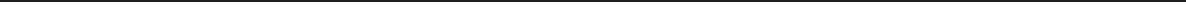
Fig. 6 ZCCHC3 binds to dsDNA and facilitates the binding of cGAS to dsDNA. a ZCCHC3 enhances the binding of cGAS to dsDNA. HEK293 cells were transfected with the indicated plasmids. Twenty hours later, the cell lysates were incubated with biotinylated-HSV120 and streptavidin-Sepharose beads for in vitro pull-down assays. The bound proteins were then analyzed by immunoblots with anti-HA and anti-ZCCHC3. b ZCCHC3-de fi ciency decreases the binding of cGAS to dsDNA in HEK293 cells. ZCCHC3-KO HEK293 clones were generated by the CRISPR-Cas9 method. ZCCHC3-KO and control HEK293 cells were transfected with HA-cGAS. Twenty hours after transfection, cells were collected for in vitro pull-down assays similarly as in a . c ZCCHC3-de fi ciency decreases the binding of endogenous cGAS to dsDNA in MLFs or MEFs. Zcchc3 + / + and Zcchc3 − / − MLFs or MEFs were collected for in vitro pull-down assays. The bound proteins were then analyzed by immunoblots with anti-cGAS and anti-ZCCHC3. d MST measurement of binding af fi nities. Binding af fi nities between the indicated recombinant proteins as well as between the indicated recombinant proteins and synthetic dsDNA HSV60 were measured by MST. The puri fi ed recombinant proteins were stained with Coomassie blue (right gel). e Effects of reconstitution of ZCCHC3 or ZCCHC3 (1-340) on HSV-1-induced transcription of downstream genes in Zcchc3 − / − MLFs. Zcchc3 − / − MLFs were reconstituted with murine ZCCHC3 or ZCCHC3(1-340) by lentiviral-mediated gene transfer. The reconstituted MLFs were left un-infected or infected with HSV-1 for 6 h before qPCR analysis. f Effects of ZCCHC3 on transcription of downstream genes induced by HSV120 in cGas + / + and cGas − / − L929 cells. cGas + / + and cGas − / − L929 cells stably expressing ZCCHC3 were transfected with HSV120 (3 μ g/ml) for 4 h before qPCR analysis. *P < 0.05, **P < 0.01 (unpaired t test). Data are representative of at least two experiments with similar results (mean ± SD, n = 3 independent samples in e , f